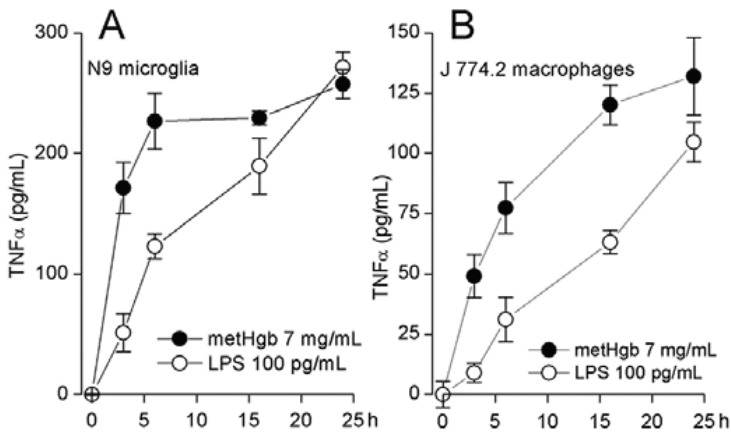
Figure 4. metHgb causes time-dependent secretion of TNF α from microglia and macrophages. ( A , B ) Cultured N9 microglia ( A ) and J 774.2 macrophages ( B ) were exposed to purified LPS-free metHgb (7 mg/mL) or LPS (100 pg/mL), as indicated; TNF α secretion into